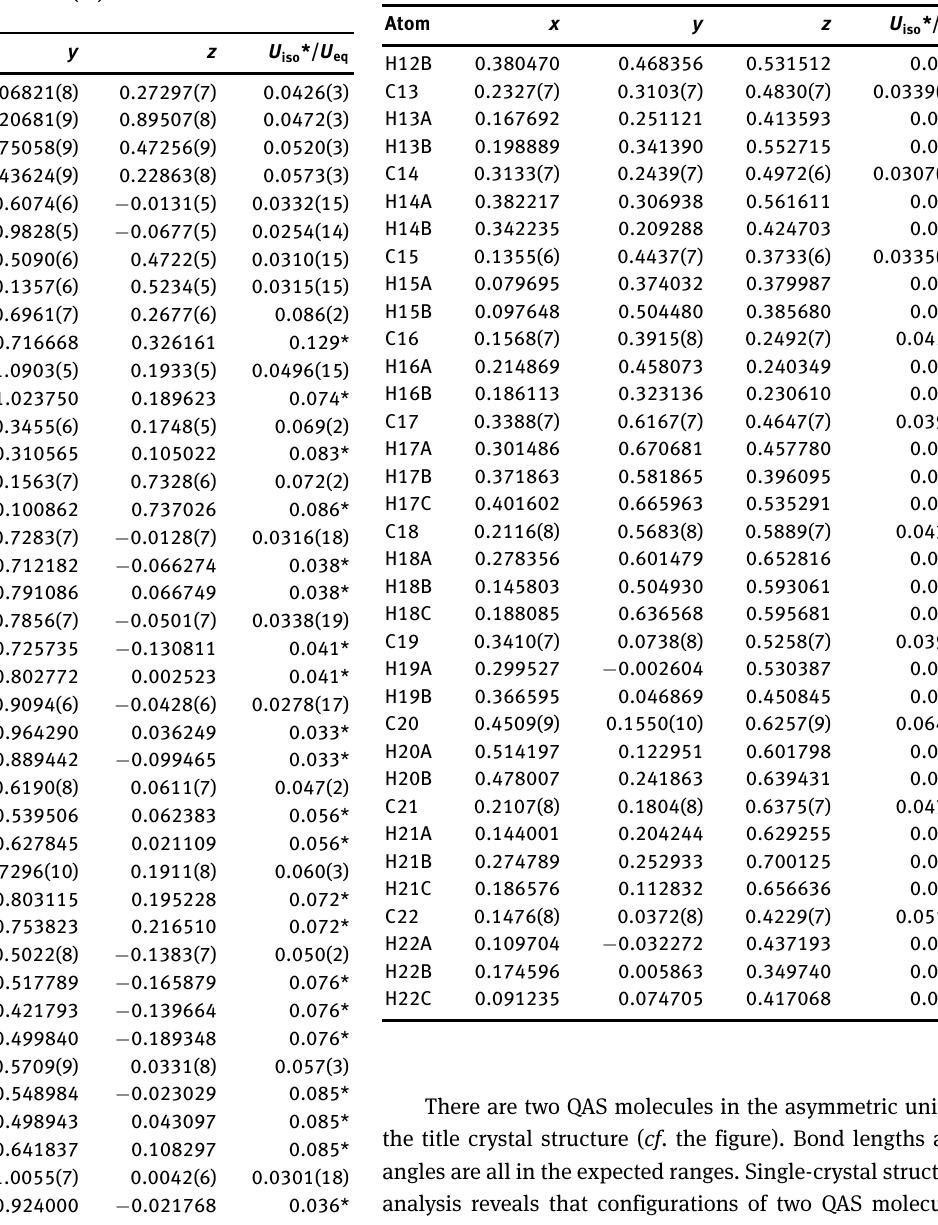
Table 2: Fractional atomic coordinates and isotropic or equivalent isotropic displacement parameters (Å 2